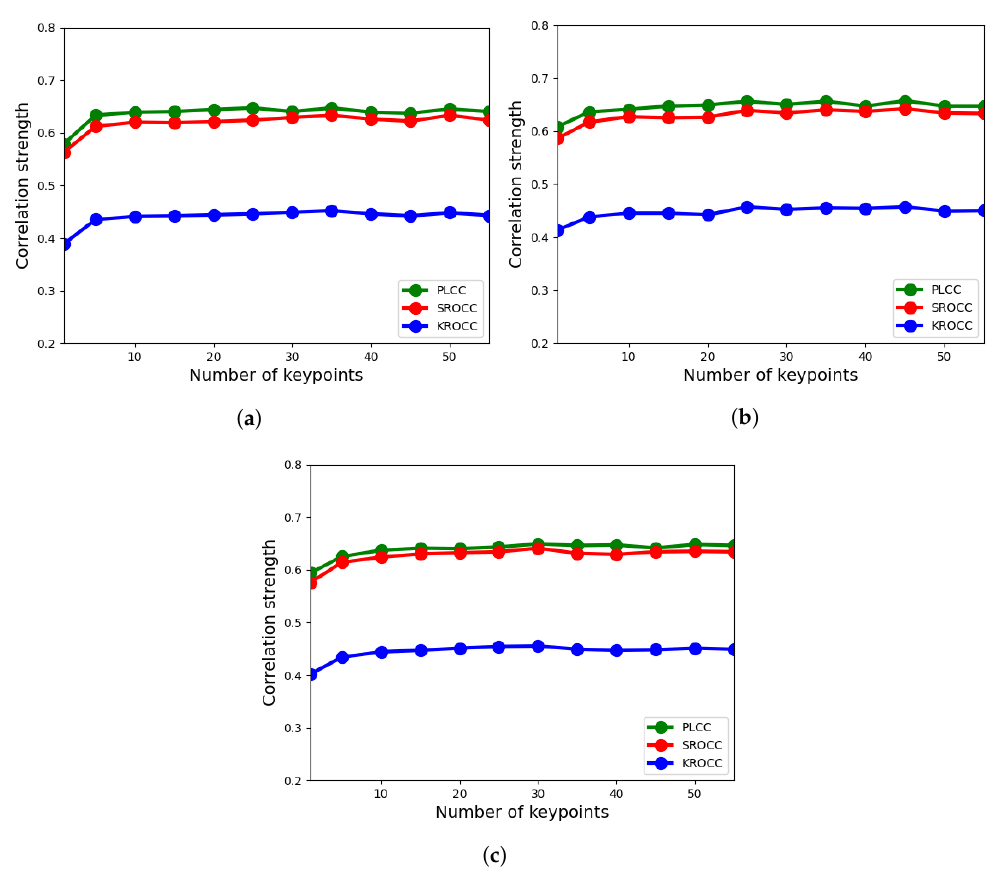
Figure 6. Ablation study for LFD-IQA-SVR: number of detected keypoints vs. correlation strength. ( a ) 3 × 3 block size, ( b ) 5 × 5 block size, ( c ) 7 × 7 block